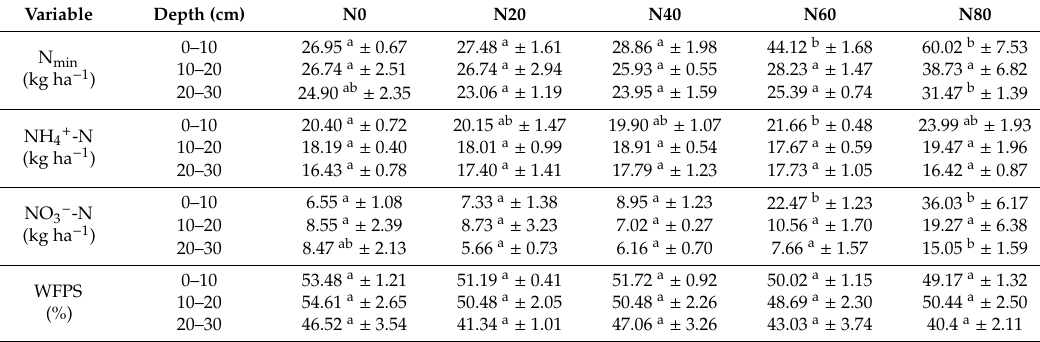
Table 2. The mean ( ± standard error) mineralizable nitrogen (N min ), NH 4 + -N, NO 3 − -N, and the water-filled pore space (WFPS) for the N fertilization treatments (N0, N20, N40, N60, and N80) for soil depths 0–10, 10–20, and 20–30 cm. The standard error of the mean is shown in brackets. The N0, N20, N40, N60, and N80 refer to the di ff erent treatments used and were 0, 220, 440, 660, and 880 kg N ha − 1 year − 1 , respectively. Means in the same row with no common superscript di ff ered ( p < 0.05). Variable Depth (cm) N0 N20 N40